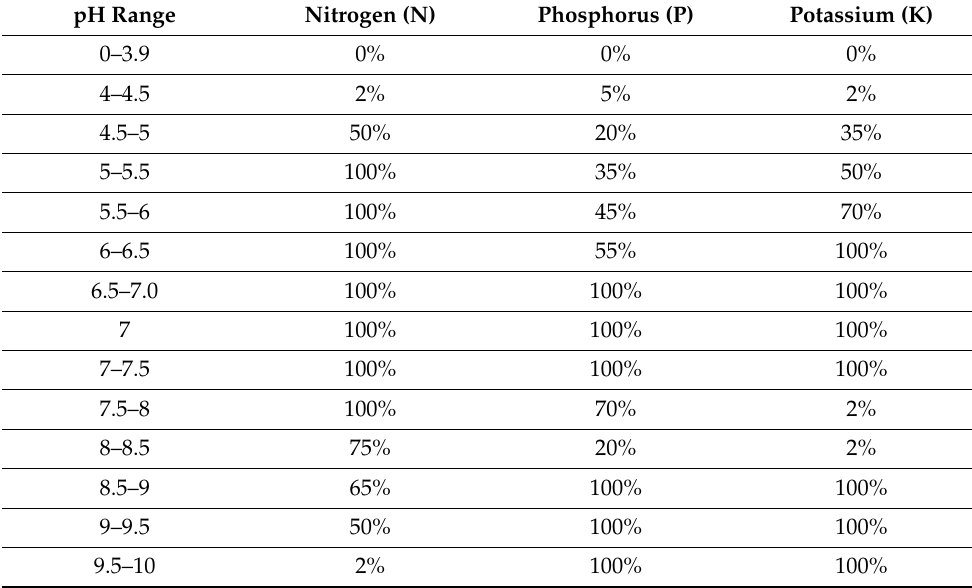
Table 2. Soil pH and corresponding estimation of N, P, and